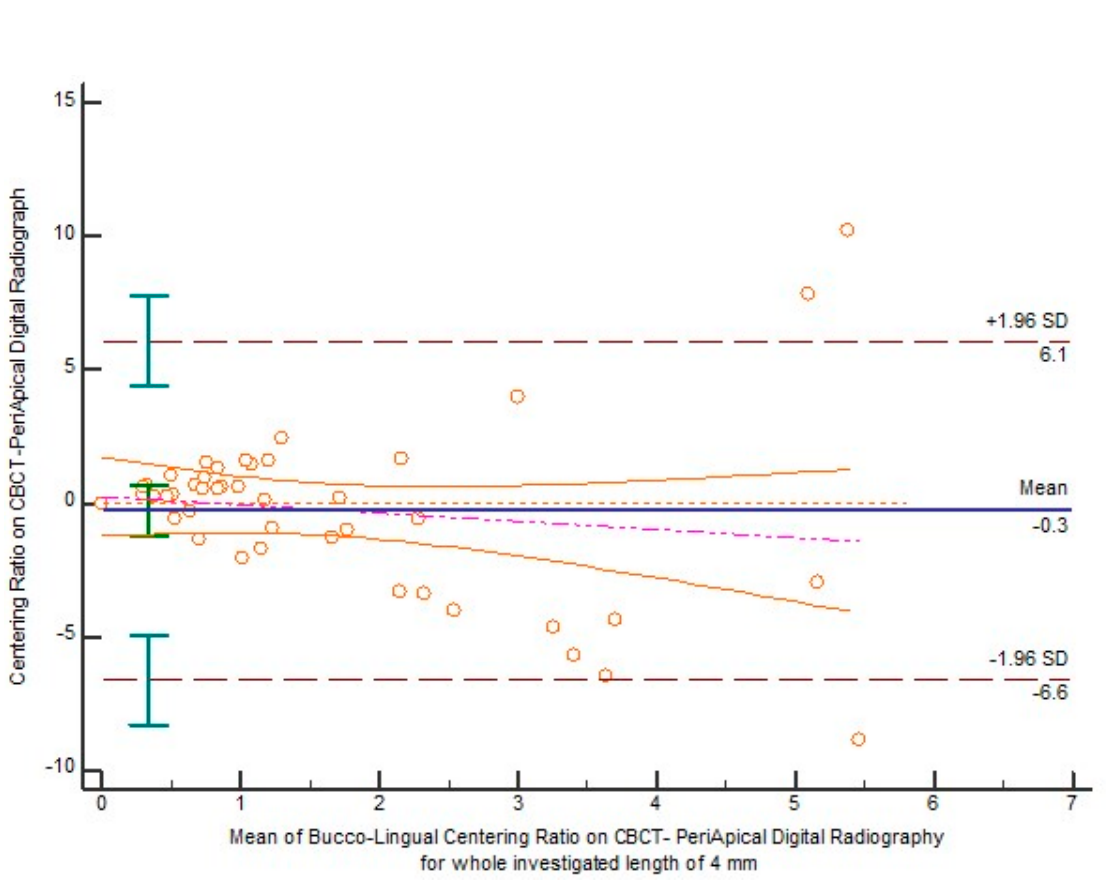
Figure 8. Bland–Altman plot for the agreement between the two methods’ measurements for the centering ratio in the bucco-lingual direction, for the whole investigated length of 4